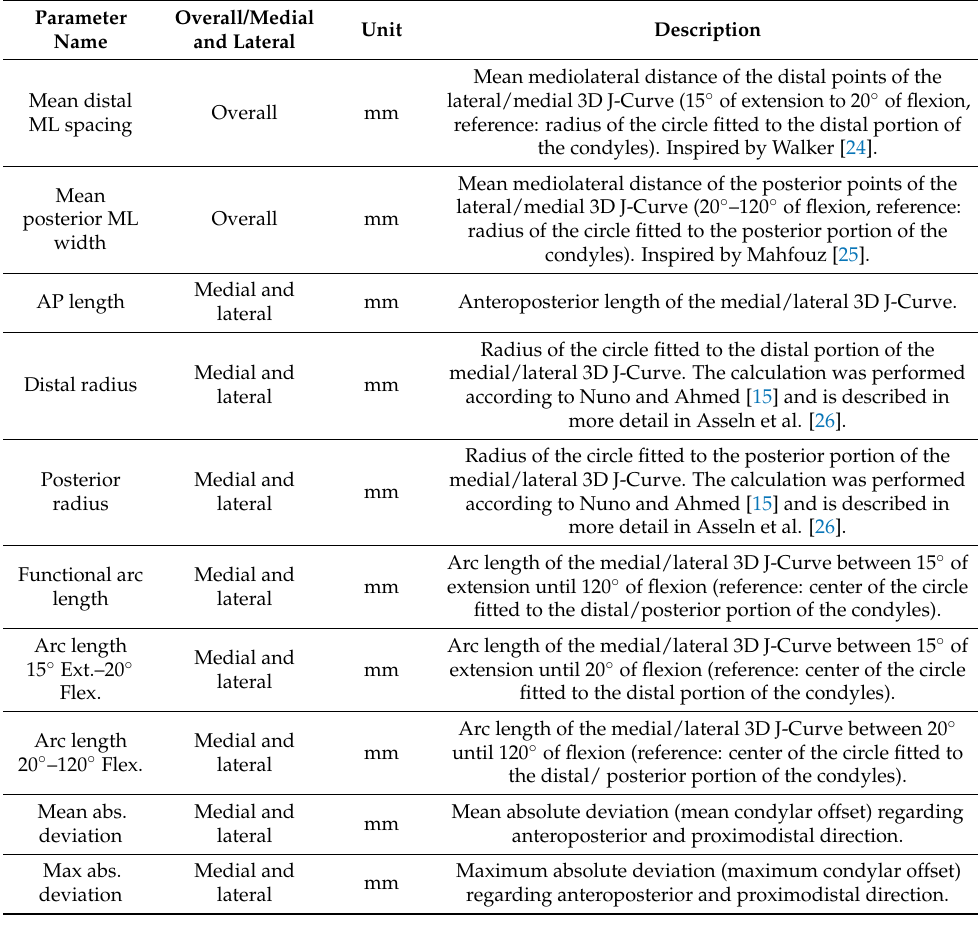
Table 1. Description of the parameters considered in the geometric parameter analysis. Parameters are either defined for the combined overall shape of both J-Curves or individually for the medial and lateral side (column: overall/medial and lateral).